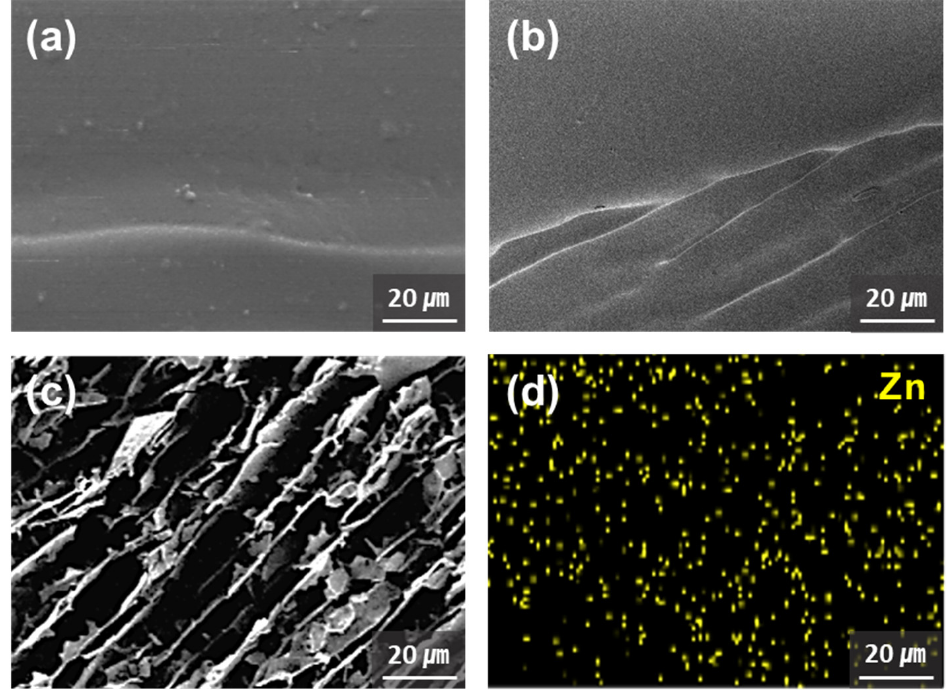
Figure 3. SEM images of ( a ) SF-BGE, ( b ) SF-BGE/TA, and ( c ) SF-BGE/TA/ZnO hydrogel. ( d ) EDS mapping image of the SF-BGE/TA/ZnO hydrogel.